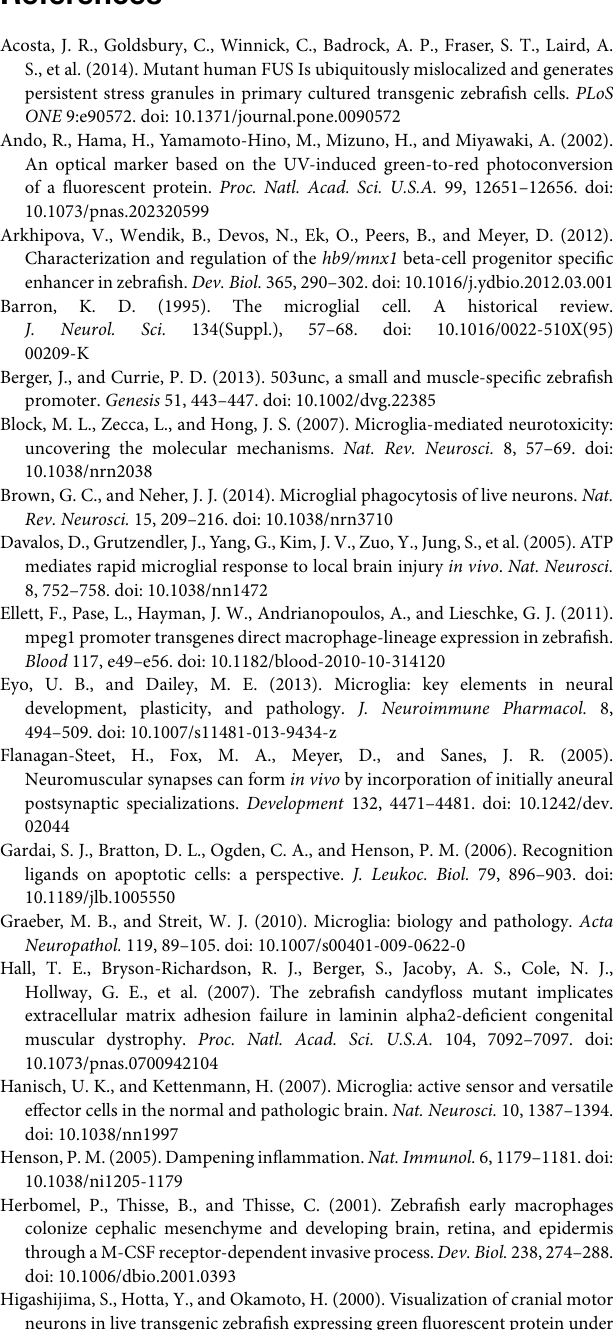
Supplementary Video 6 | Imaris 3D-rendering of the same microglia response shown at Supplementary Video 5. This method clearly reveals the formation of a phagosome-like structure (5min/frame). Supplementary Figure S1 | UV laser irradiation induces neuronal damage in a dose-dependent manner. UV laser ablation with different laser power ( A : 15%; B : 30%; C : 60%, and D : 90%) of the s1020t:Kaede expressing neurons (green) in the spinal cord shows the focal spread of the UV laser, indicated by